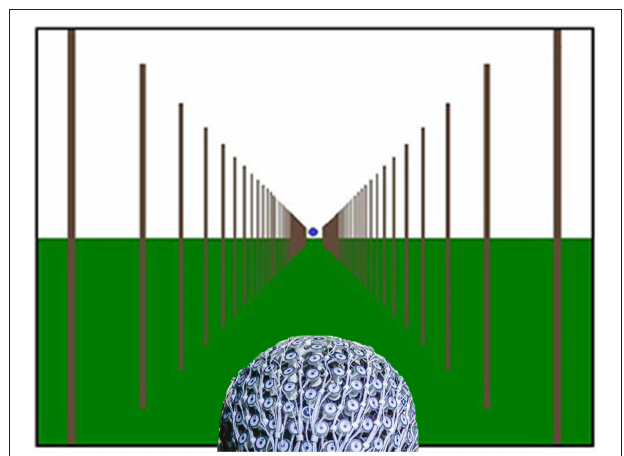
FIGURE 1 | Optic flow pattern simulating forward motion down a virtual road with a subject wearing the Geodesic Sensor Net. Blue dot in the center of the screen represents gaze data and indicates where participants were instructed to look, but was not present during the experiment (Supplementary Video